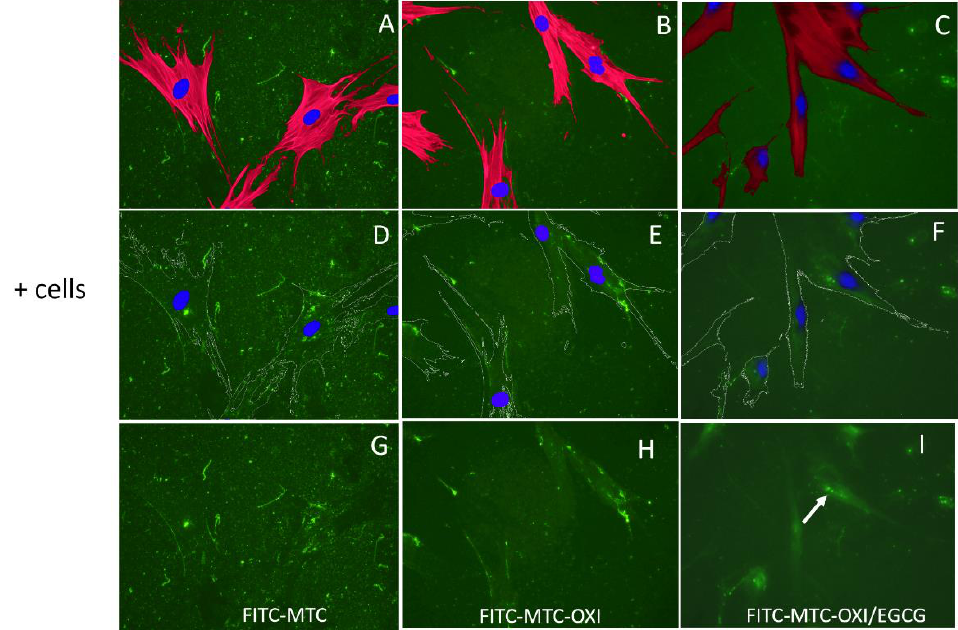
Figure 3. The overall morphology of ADSCS adhering to regular collagen ( A , D , G ), oxidized colla- gen ( B , E , H ), and oxidized collagen pretreated with EGCG ( C , F , I ). The top images ( A – C ) present the overall cell morphology viewed by the actin cytoskeleton (red) and cell nuclei (blue) on the green, fluorescent background of FITC collagen. The middle row ( D – F ) presents the substratum (green) with artificially superimposed cell contours and nuclei, while the bottom row ( G – I ) presents the collagen substratum only.